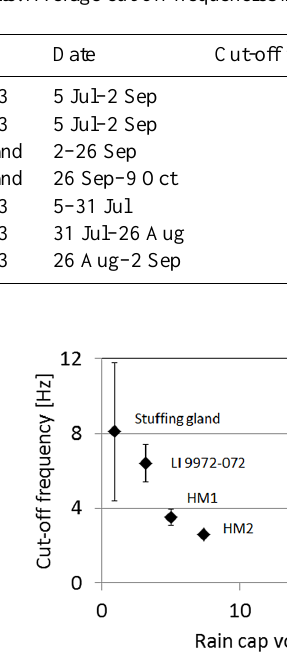
Table 1. Schedule of filter, flow rate and rain cap design used at the field site. Average cut-off frequencies measured on each system tested.